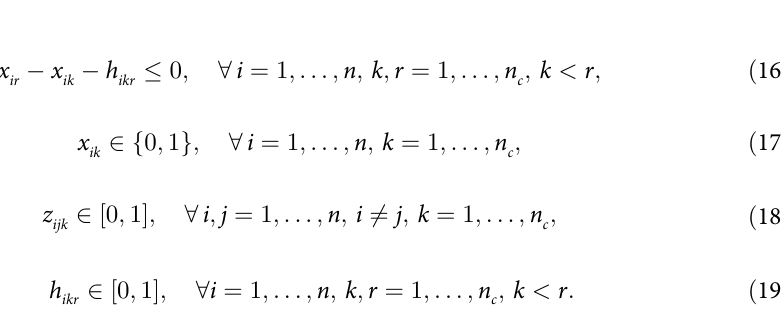
Fig 1. Zachary’s karate club structure obtained by F Community 3.